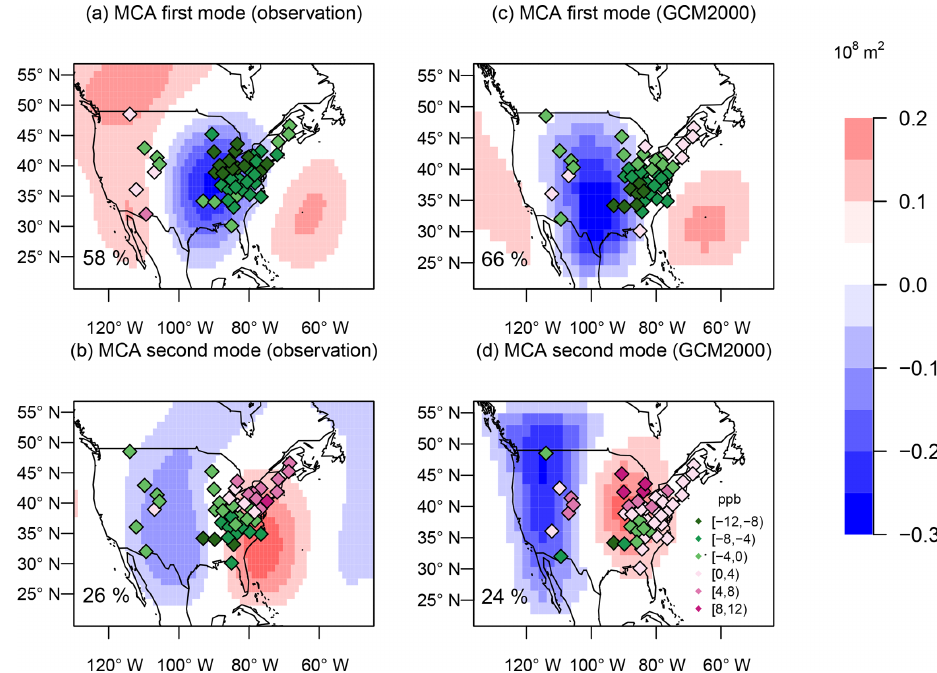
Figure 3. Spatial patterns of JJA AWA (color shades; in 10 8 m 2 ) and MDA8 ozone (colored diamonds; in ppb) from the maximum covariance analysis of AWA within the analysis domain and ozone at the CASTNET stations. The first mode (a) and the second mode (b) are from ERA- Interim meteorology and measured ozone at the CASTNET sites. Panels (c, d) are as in panels (a, b) , except from the GCM2000 simulation of AWA and ozone at grid points closest to the CASTNET sites. The percent variance explained by each mode is given in the lower-left corner of each